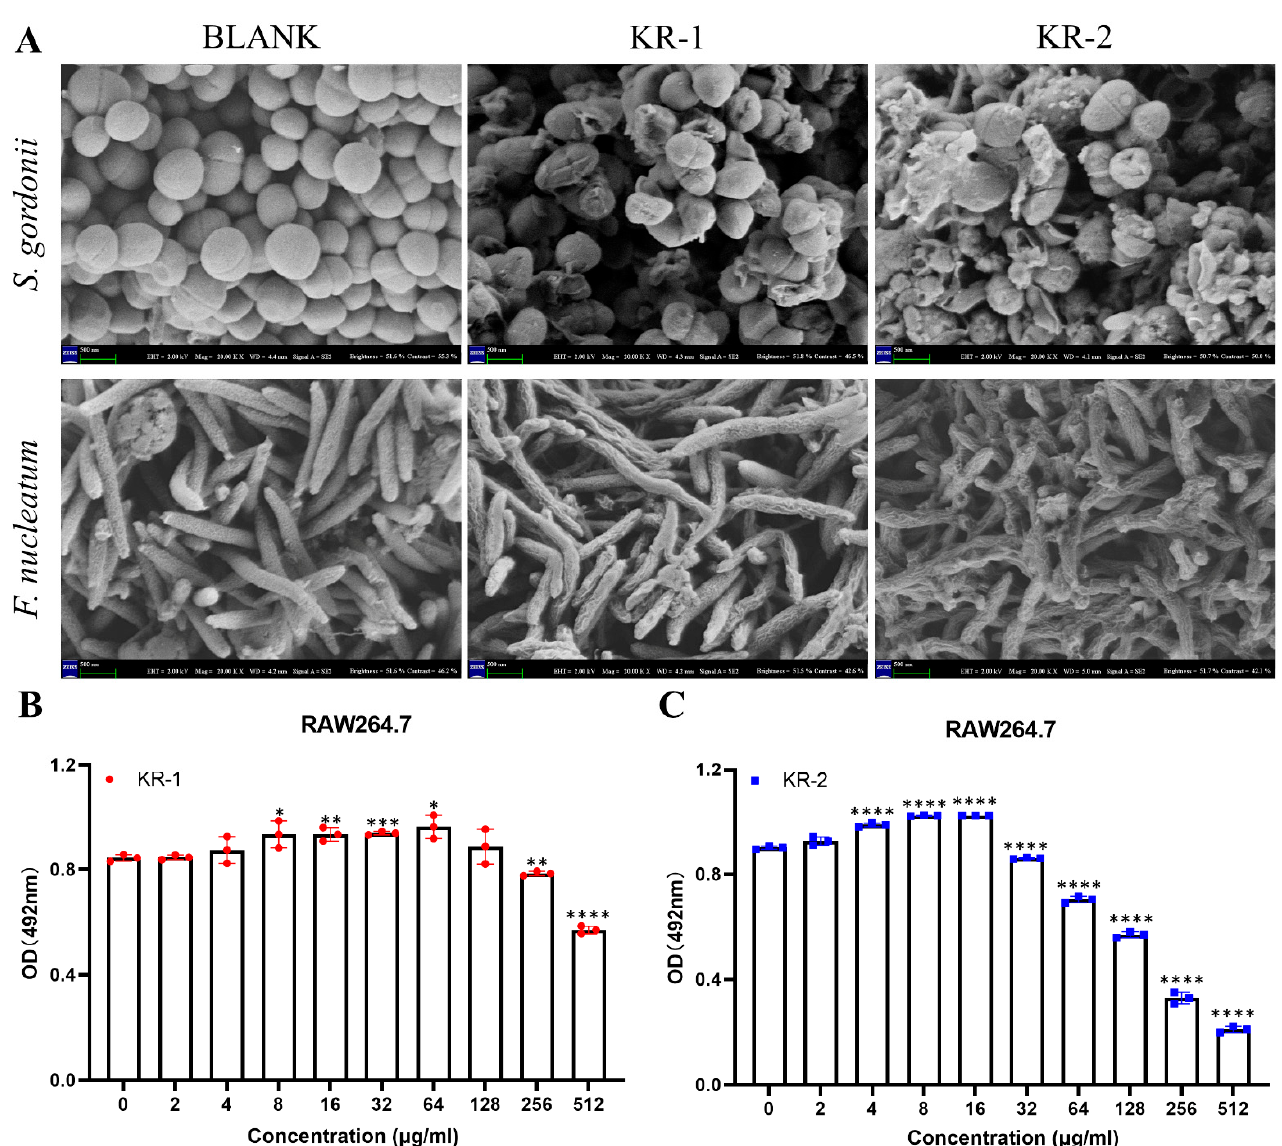
Figure 3. ( A ) S. gordonii and F. nucleatum were treated with KR − 1 and KR − 2, respectively, and the changes in bacterial morphology were observed under scanning electron microscope. ( B , C ) CCK-8 results of RAW 264.7 when KR − 1 and KR − 2 were added to the culture for 3 days. Note: data are presented as mean ± standard deviation ( n = 3). * Indicates statistical significance between the BLANK group and other groups. (* p < 0.05, ** p < 0.01, *** p < 0.001, and **** p < 0.0001, ANOVA).